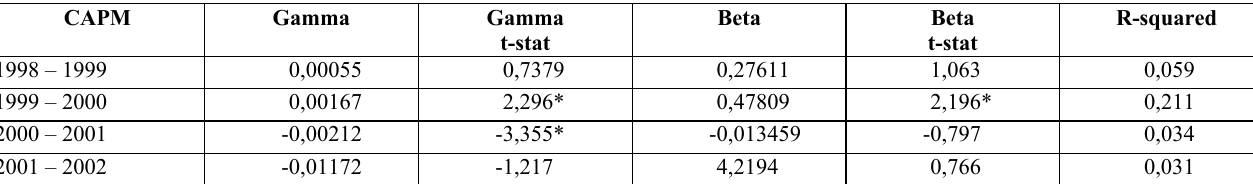
Table 4: Persistence in performance predicted by the CAPM alpha values CAPM